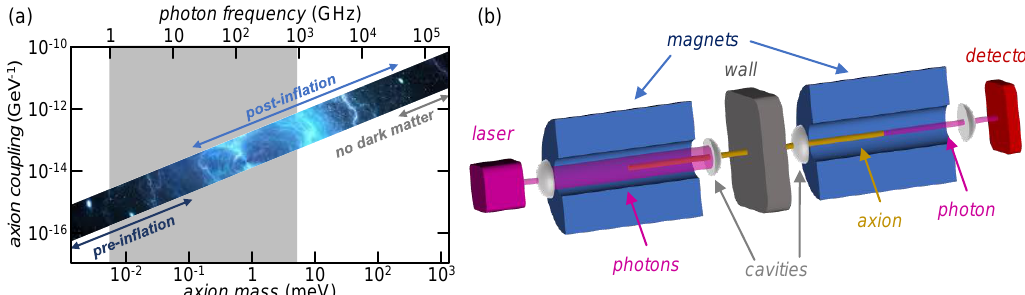
Figure 1. Laboratory axion search. ( a ) Photon-axion coupling ( g ) versus axion mass, where axions origins are indicated. The diagonal band shows the parameter space consistent with the quantum chromodynamics (QCD) axion from the Peccei-Quinn theory. The grey area depicts the operating range of the detectors presented in this review. ( b ) Conceptual representation of a light-shining-through-wall (LSW) experiment. A laser (violet) feeds photons in a Fabry-Perot cavity immersed in a constant magnetic field. An axion is generated by the conversion of a photon through Primakoff effect and passes through the wall (grey). The axions converts back in a photon of same energy in the second magn etic field area and is revealed by a single-photon detector